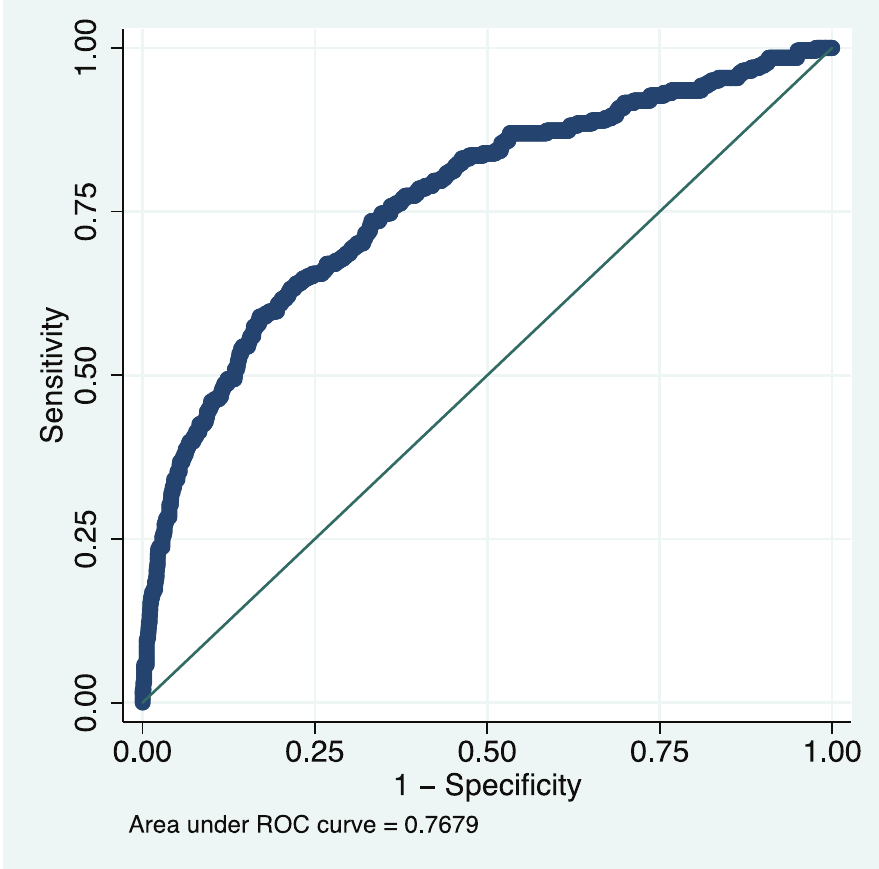
Figure 2. Receiver operating characteristic curve of the miniPIERS model developed in 2,081 women in the miniPIERS cohort. AUC 0.768 (95% CI 0.735–0.801).